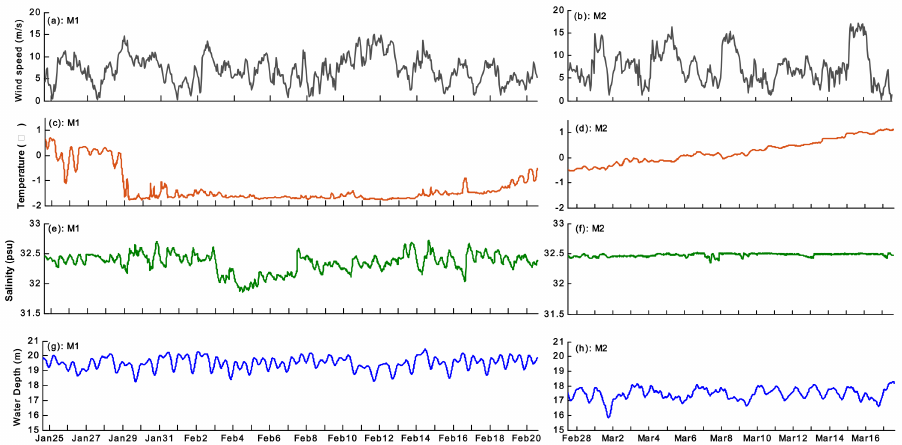
Figure 3. Changes in wind speed ( a,b ), temperature ( c,d ), salinity ( e,f ), and water depth ( g,h ) at stations M1 and